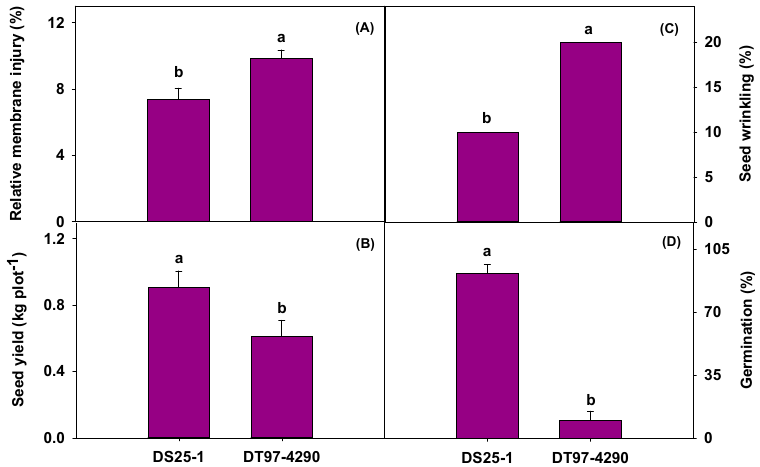
Figure 1. Relative membrane injury in leaves ( A ), seed yield ( B ), seed wrinkling ( C ), and seed germination ability ( D ) of soybean genotypes DS25-1 and DT97-4290 exposed to heat stress. Relative membrane injury, which is a measure of cell membrane stability, was measured on plants grown under controlled environmental conditions. These plants were exposed to heat stress (38/28 °C) for 7 d during the seedling stage. Seed yield, wrinkling, and germination ability were measured on plants grown under field conditions at Stoneville, MS during April–September 2019. Plants experienced > 35/25 °C (supra-optimal temperatures) on >50 days during the life cycle due to hot weather conditions at Stoneville. Seed yield and wrinkling were measured for plants harvested at growth stage, R8 (full maturity), whereas seed germination ability was measured for plants harvested 14 d after growth stage, R8.